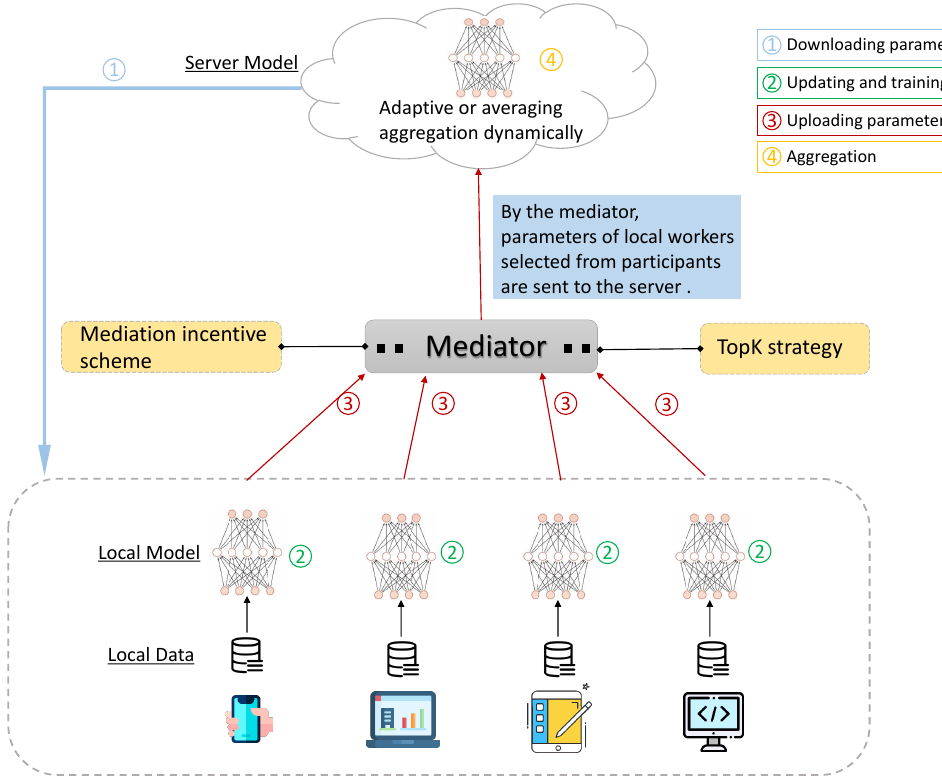
Figure 1. The illustration of how FedMed methodology works. Stage 1 indicates local workers download global model to devices; stage 2 represents worker models training on local data; stage 3 shows local workers upload neural network model parameters to the Mediator; and stage 4 stands for the global server aggregating worker model